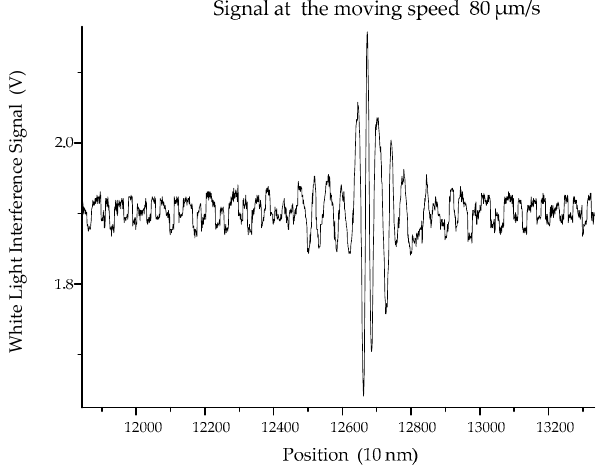
Figure 9. Positioning signal at moving speed of 80 µm/s.